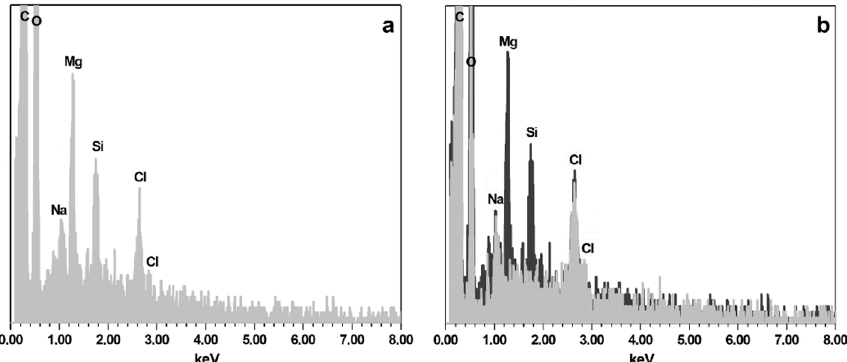
Figure 4. Characteristic chemical analyses obtained on the fibers of Figure 3. ( a ) Representative EDS spectrum recorded on the fibers in Figure 3a,c. The relative intensities of Mg and Si peaks identify chrysotile, a mineral regulated as asbestos. Na and Cl peaks are produced by NaCl crystallization during the digestion process. ( b ) Superimposition of the spectrum reported in ( a ) and the spectrum recorded in an area exterior to the fibers. The fiber is composed by Si and Mg, with relative intensities allowing, together with the morphological features, identification of chrysotile.